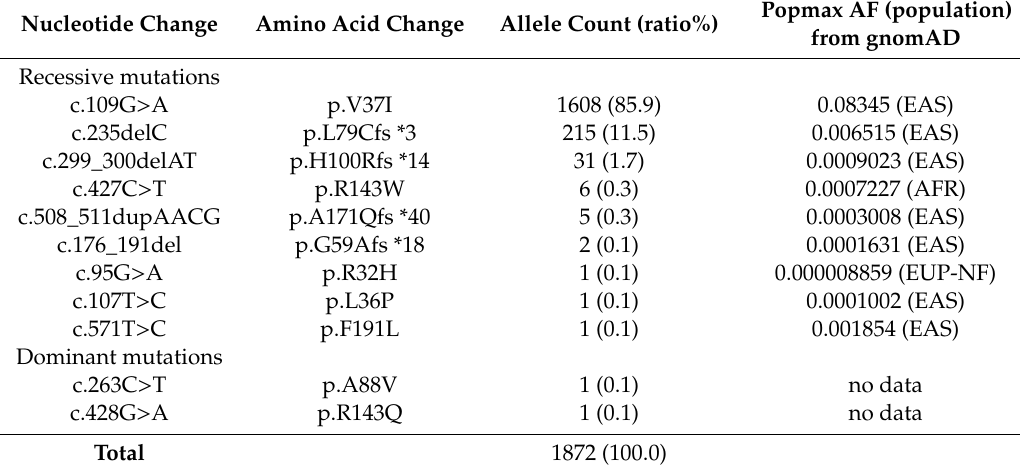
Table 2. GJB2 mutations detected in the Taiwanese